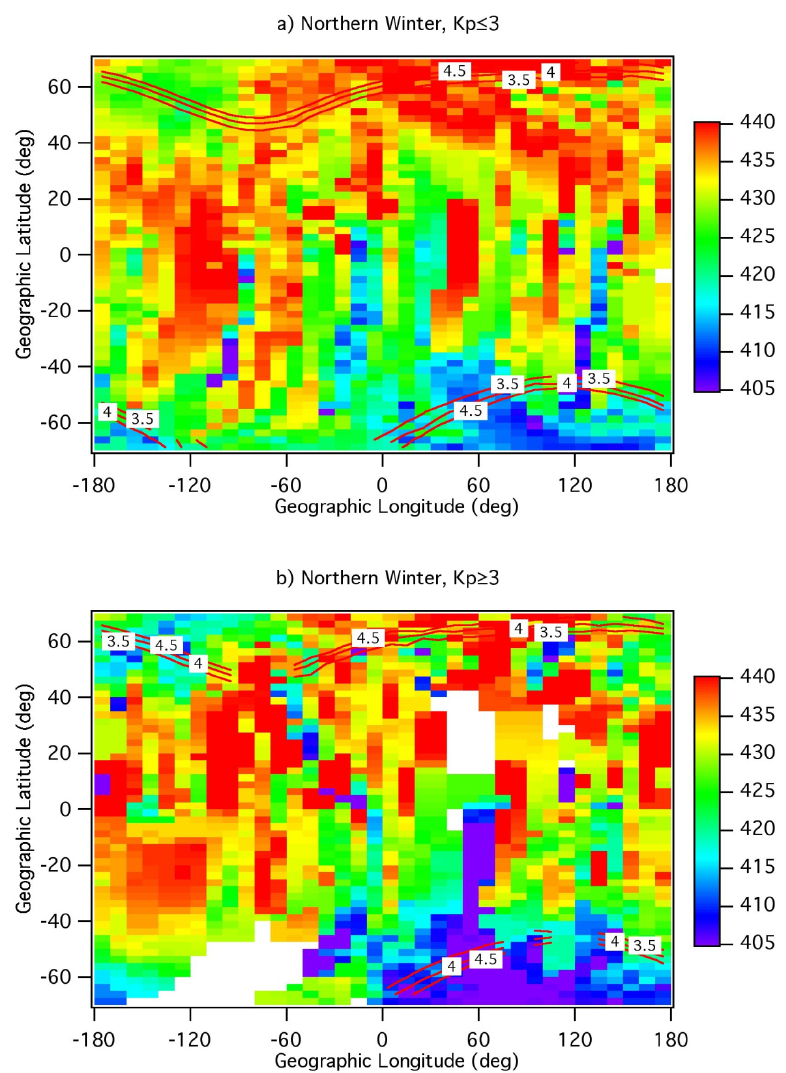
Fig. 4. AE-C: Maps of P -parameter for northern winter for (a) quiet magnetic conditions ( K p ≤ 3 above) and (b) disturbed magnetic conditions ( K p ≥ 3, below). Red curves show magnetic L